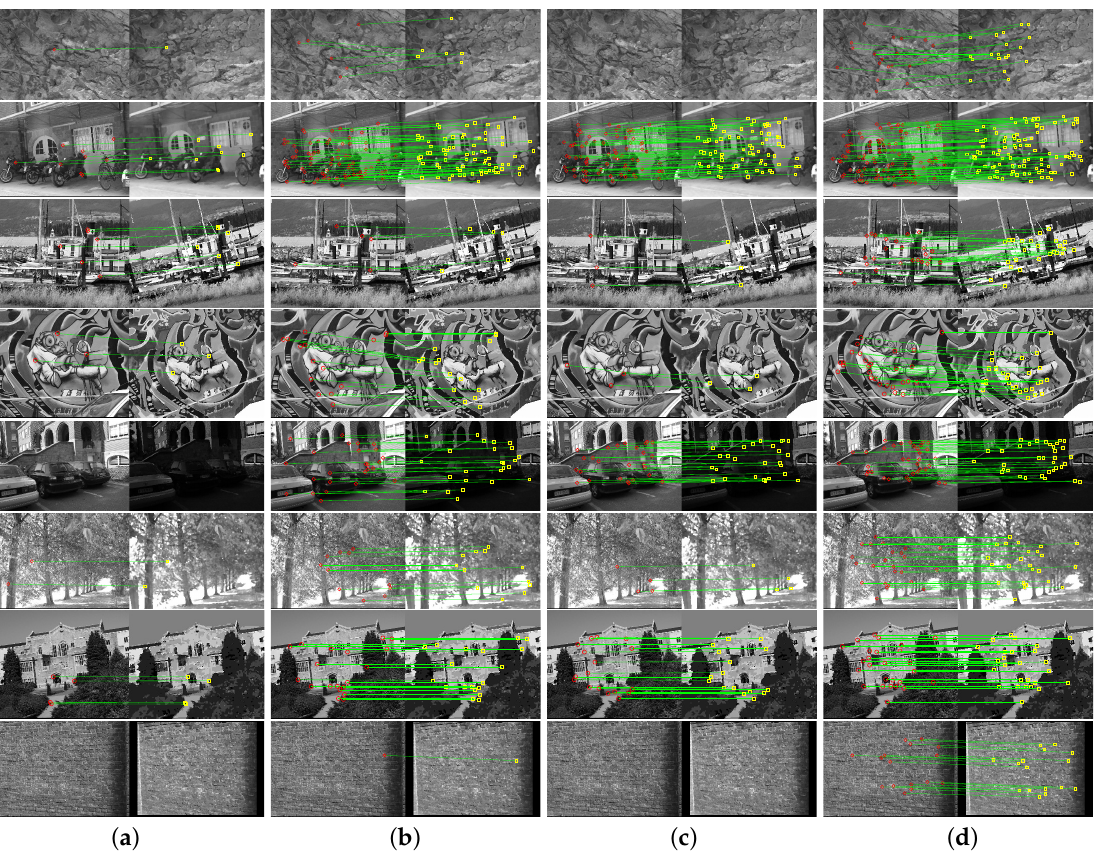
Figure 14. Matching results of Oxford database: ( a ) Harris results; ( b ) SIFT results; ( c ) PCA-SIFT results; ( d ) our results. Table 2. Correct numbers in the matching test on the Oxford